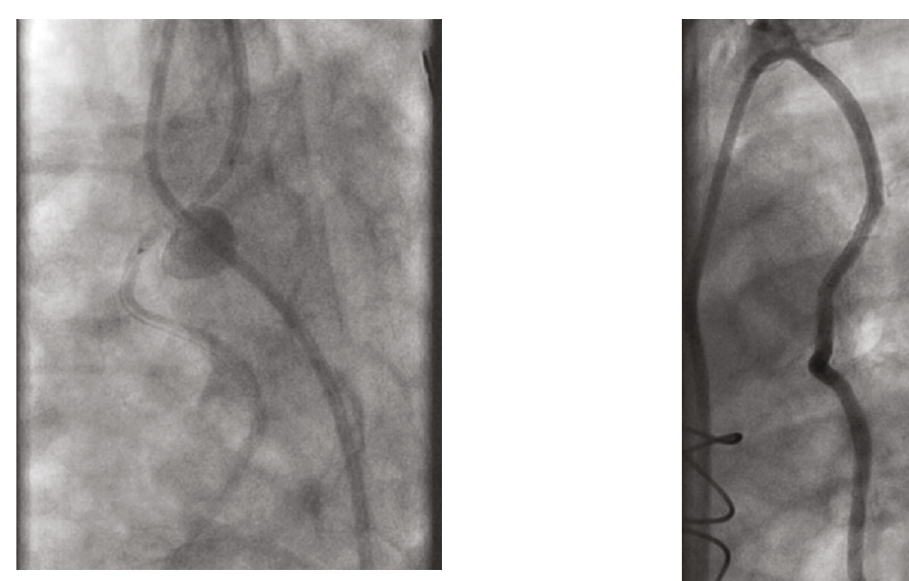
Figure 2: Covered stent placement in the midsegment of a large left internal mammary artery bypass graft aneurysm.